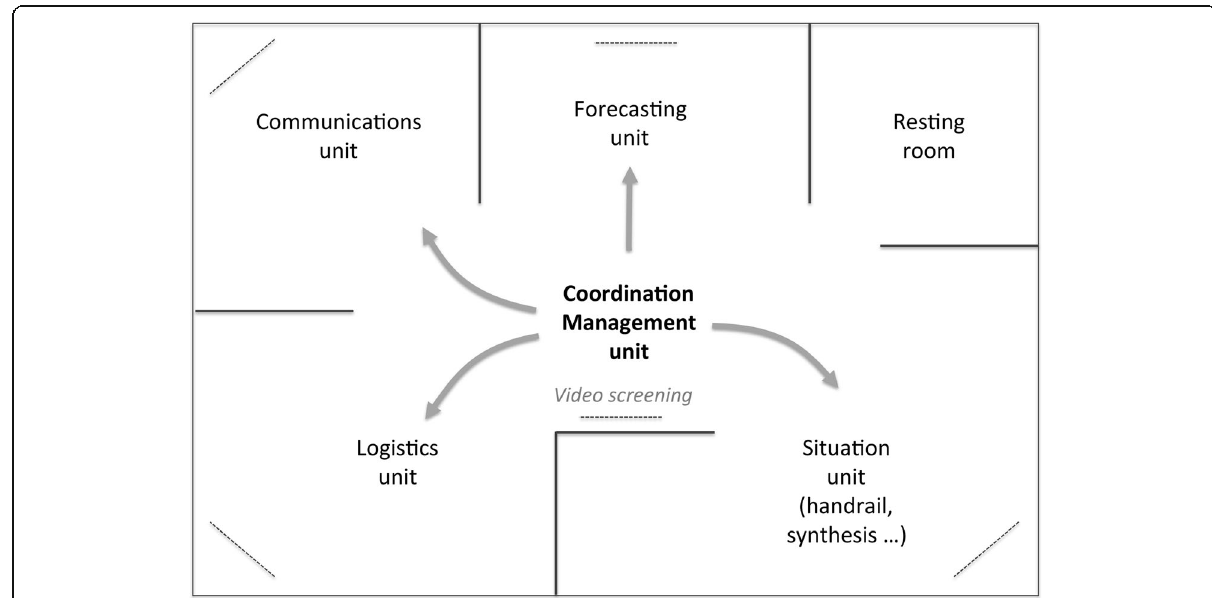
Fig. 7 Example of proposed reorganization of the PCC suggested in the exercise debrief